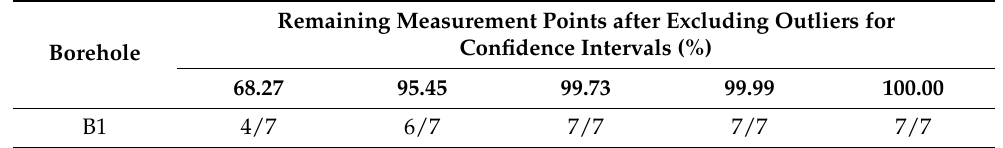
Table 2. The number of measurement points for borehole B1 after the exclusion of atypical values. Remaining Measurement Points after Excluding Outliers for Confidence Intervals (%) Borehole 68.27 95.45